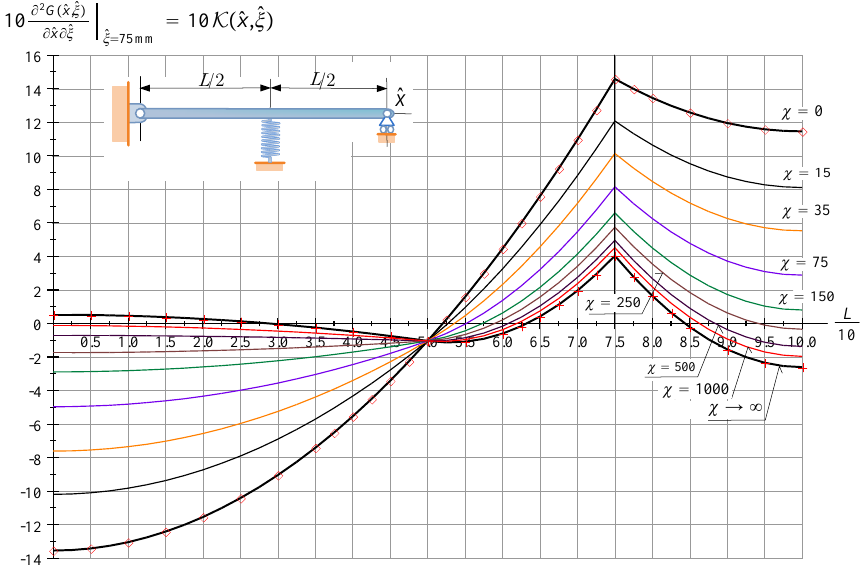
Figure 7. The kernel function of a PssP beam against x = ˆ x / L ; χ is a parameter and ξ =